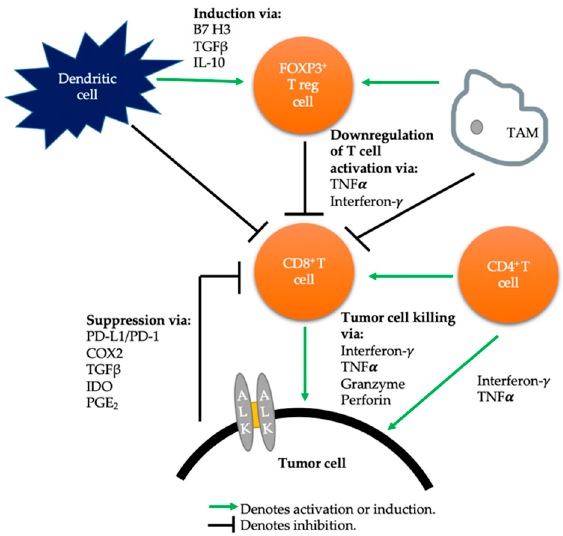
Figure 1. Tumor microenvironment in ALK-wildtype non-small cell lung cancer. TGF β : Trans- forming Growth Factor β . IL-10: Interleukin 10. TNF α : Tumor necrosis factor alpha. IDO: In- doleamine 2,3-dioxygenase. PGE 2 : Prostaglandin E2. COX2: Cyclooxygenase 2.